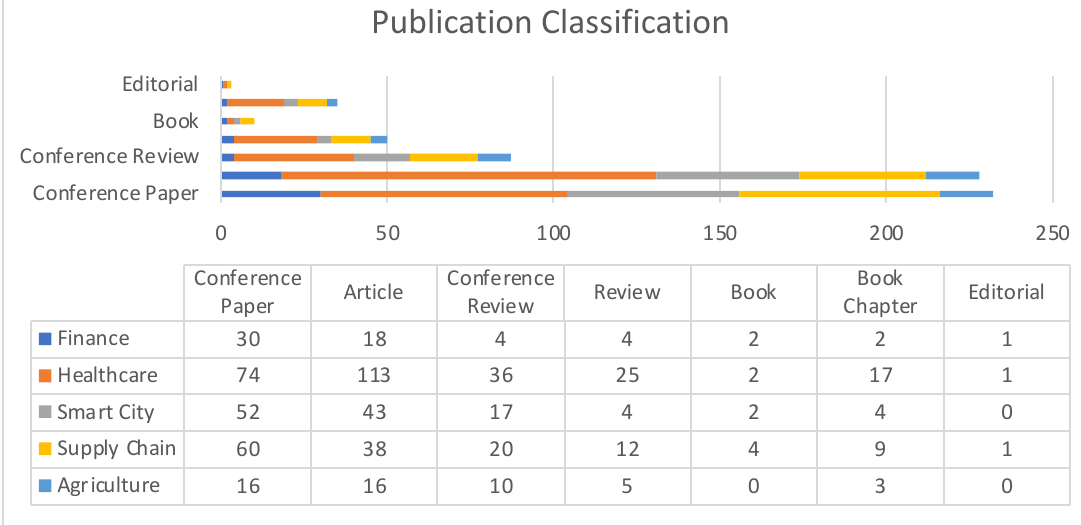
Figure 3. Publication classification comparison among application areas. Figure 4 represents the country-wise publication distribution for works concerning the use of Blockchain and Cloud in the area of Supply Chain Management. India leads from the front, followed by China and The United States. India having the maximum numbers indicates the creation of modern supply chain solutions, which is an essential part of the larger plan to be the global manufacturing